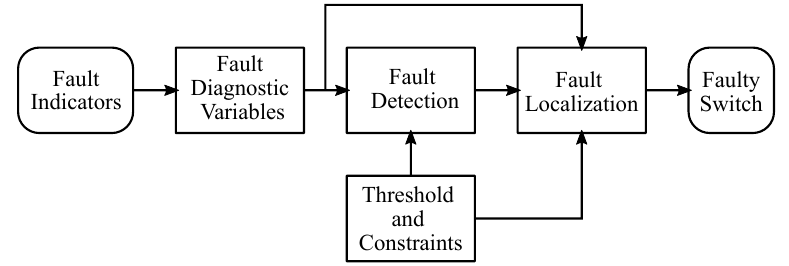
Figure 10. General schematic of fault diagnostic method.